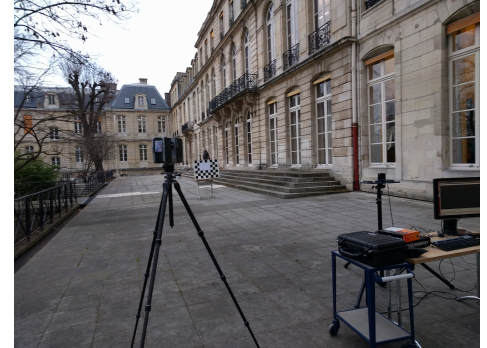
Figure 7: Experience on the evaluation of the accuracy of the distance measurement (outdoor)